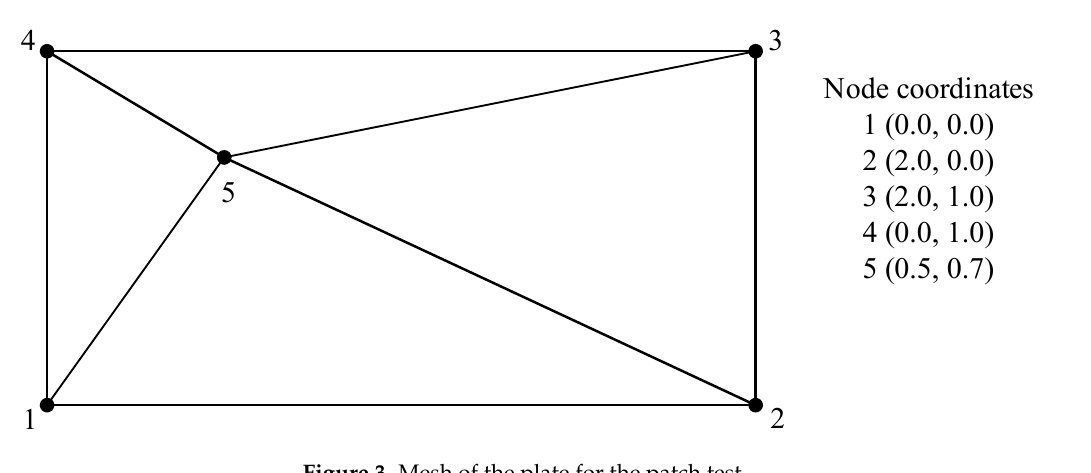
Figure 3. Mesh of the plate for the patch test. Table 1. Patch test results of the different plate elements.